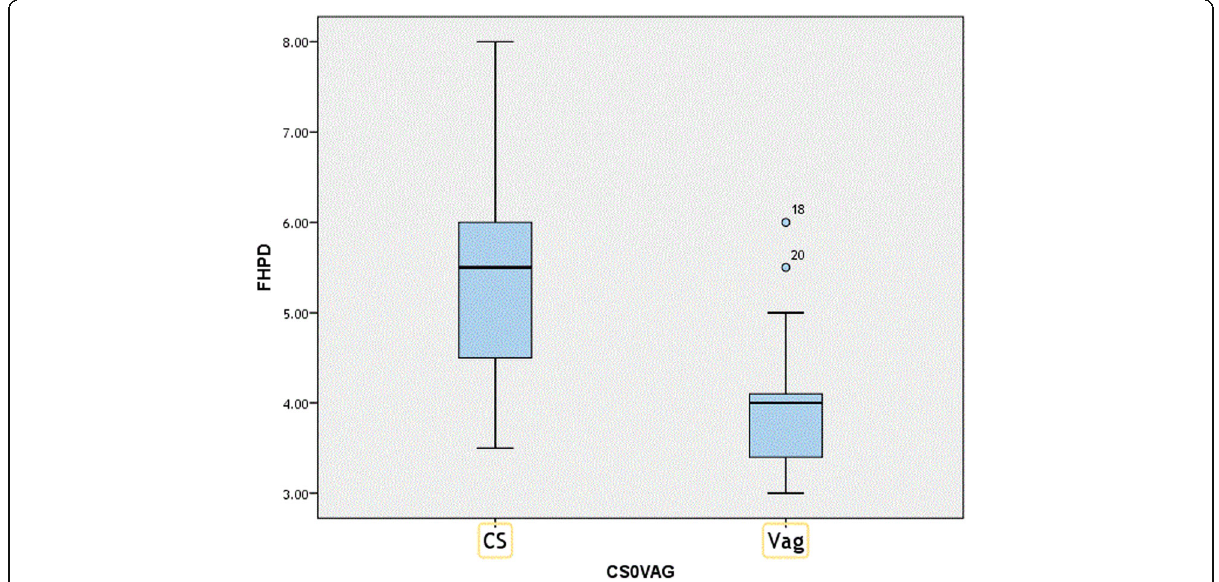
Fig. 3 Box blot diagram showing minimum, maximum values, median, and 25th and 75th percentiles of the mode of delivery and the